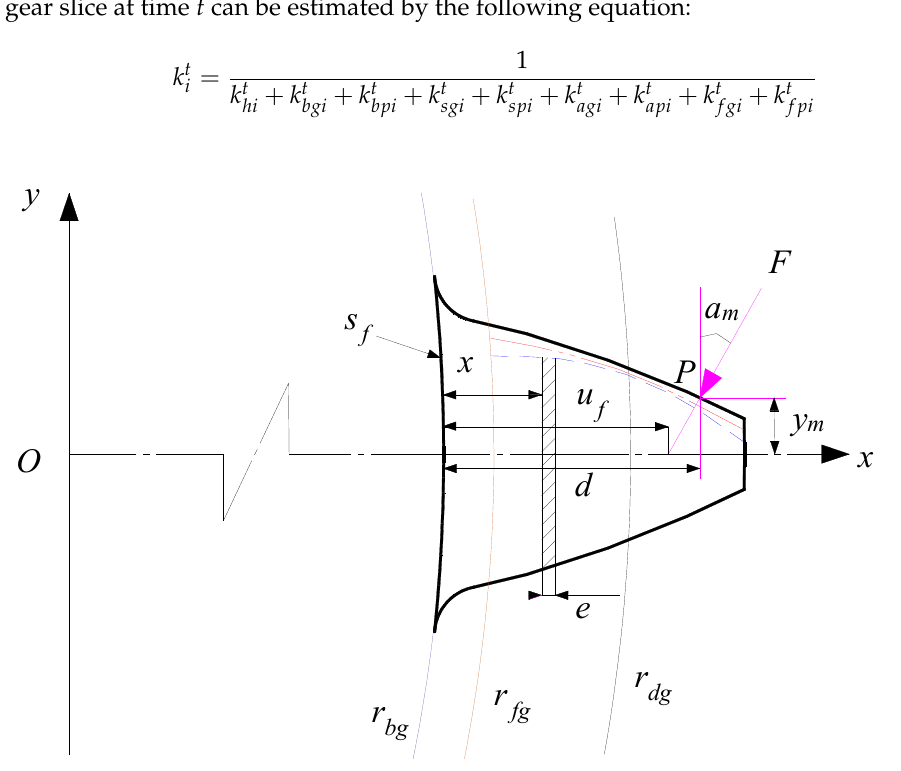
Figure 10. Gear tooth contact point under different wear depth.